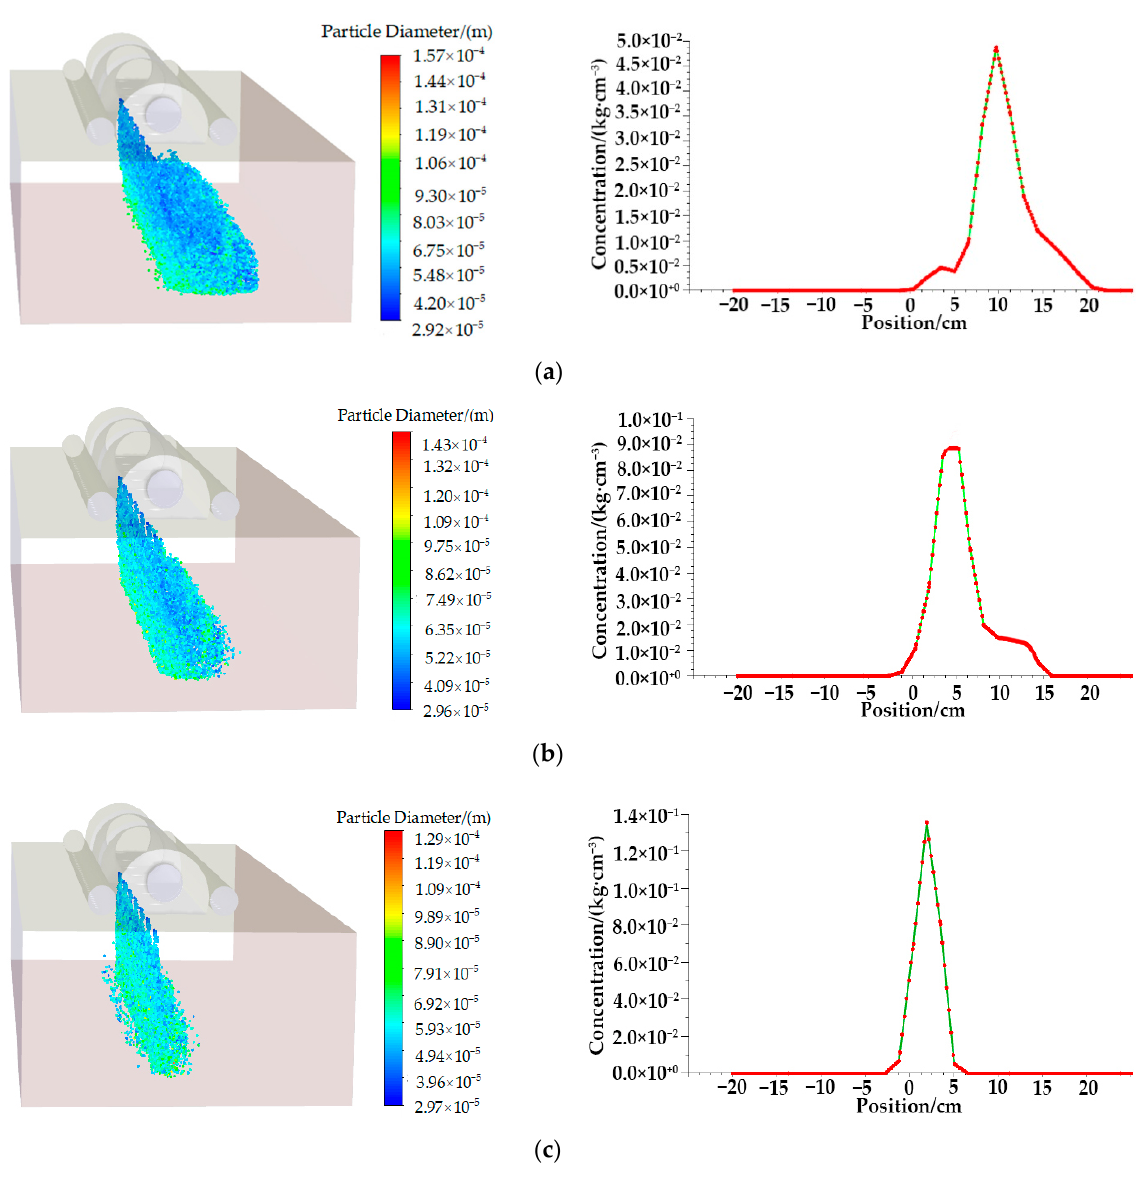
Figure 12. Droplet spatial distribution and the droplet concentration in the calibration line with different V-shaped wind speed: 15 m/s ( a ); 20 m/s ( b ); 25 m/s ( c ).